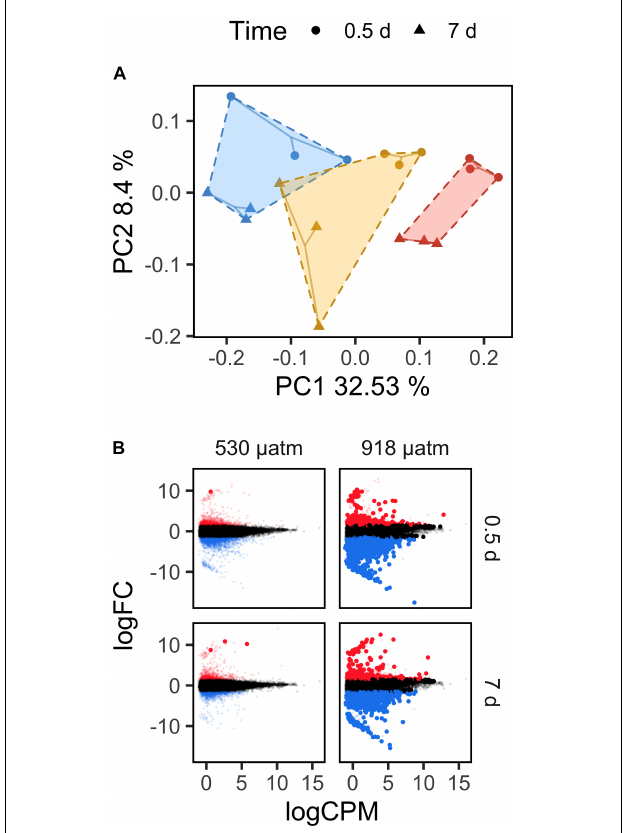
FIGURE 3 | Transcriptomic responses by Limacina helicina antarctica to current and future p CO 2 extremes. (A) Loading of RNAseq samples to latent variables derived from a principal coordinates analysis of CPM-normalized read counts. Polygons are drawn around p CO 2 255 µ atm (blue), 530 µ atm (yellow), and 918 µ atm (red) p CO 2 treatments. Replicates sampled at different times are denoted by different shapes. (B) Differential expression under 530 and 918 µ atm p CO 2 relative to 255 µ atm. Transcript log 2 foldchanges are plotted against log 2 CPM read counts. Red and blue points denote up- and down-regulated transcripts, respectively, above an absolute log 2 foldchange of 1.5. Large, solid points denote differentially expressed transcripts with an FDR p -value <